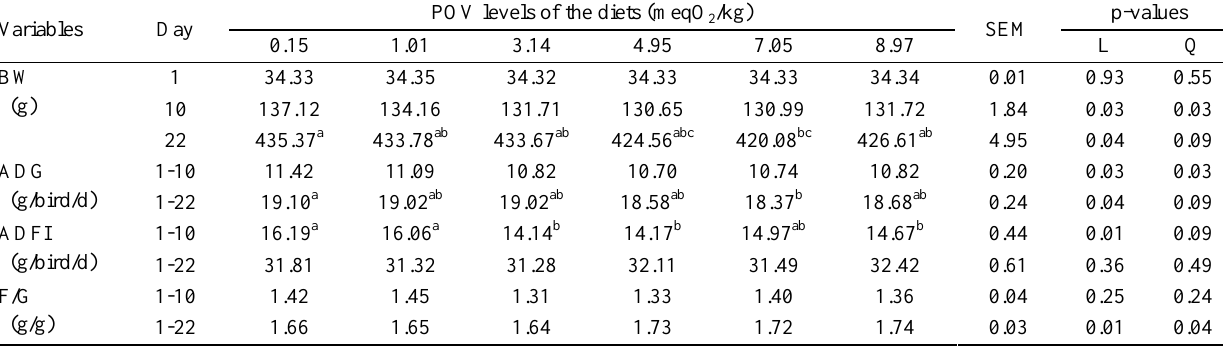
POV levels of the diets (meqO 2 /kg)